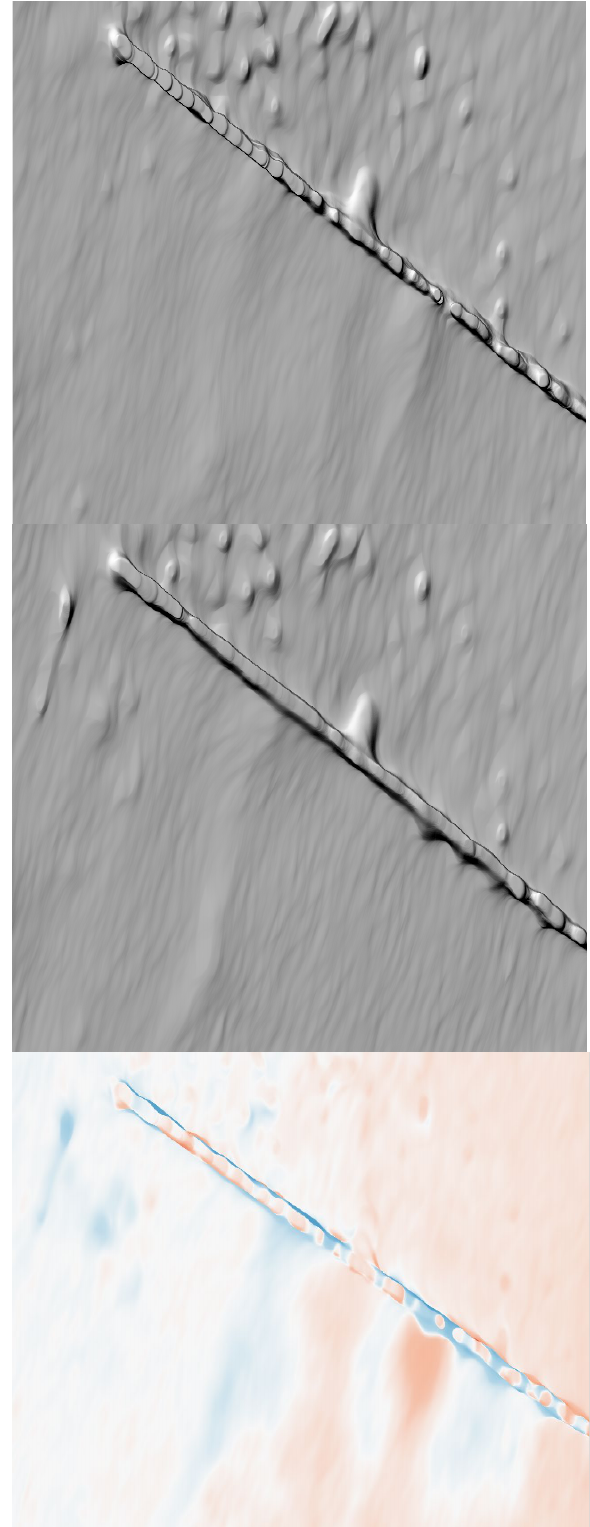
Figure 20 - TOP: Hillshade of DSM 31 st July 2020, MIDDLE: Hillshade of DSM 2 nd August 2020, BOTTOM: Erosion (Red) / Accretion (Blue) Over the 48-Hour